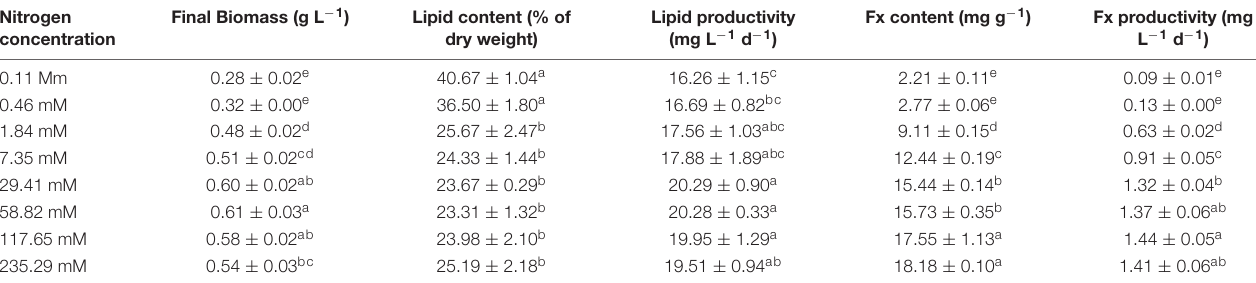
TABLE 1 | Final biomass, lipid and fucoxanthin (Fx) productivities of Nitzschia sp. NW129 grown under different nitrogen concentrations. Nitrogen